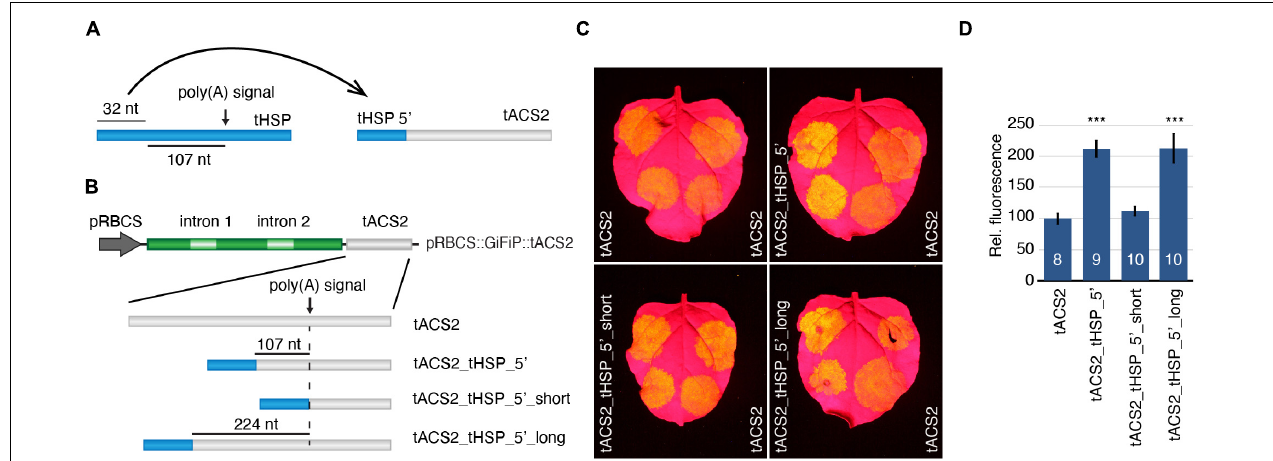
FIGURE 3 | Investigation of the capacity of the tHSP 5 (cid:48) end to improve other terminators’ efficiency. (A) Schematic of the strategy used to test the ability of the tHSP 5 (cid:48) fragment in improving the activity of weaker terminators. (B) Graphic representation of the different reporter constructs generated to test the impact of the 5 (cid:48) region of the tHSP on the activity of the ACS2 terminator. (C) Agroinfiltrated leaves representing the GFP expression obtained with different terminator constructs (left side) compared to the wild-type reference (tACS2, right side). (D) Relative GFP fluorescence of at least eight infiltration spots originating from five leaves, each leaf from a different plant (the exact number of independent measurements for each construct is indicated by the numbers in the graph columns). The standard error is shown. Statistically significant differences ( p ≤ 0.001; Mann-Whitney U test) are indicated by a